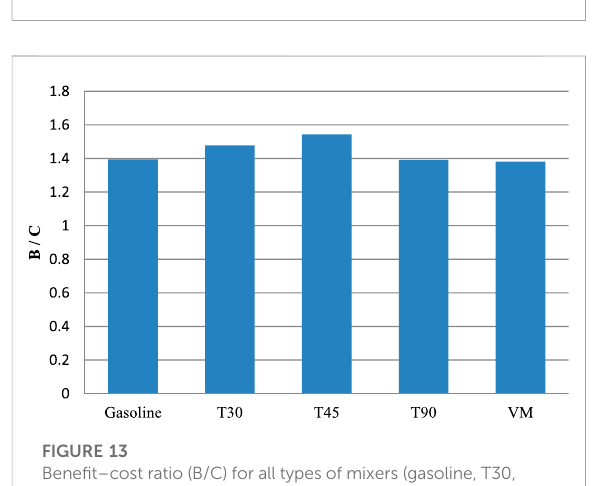
FIGURE 12 Net present value (NPV) for all types of mixers (gasoline, T30, T45, T90, and VM).